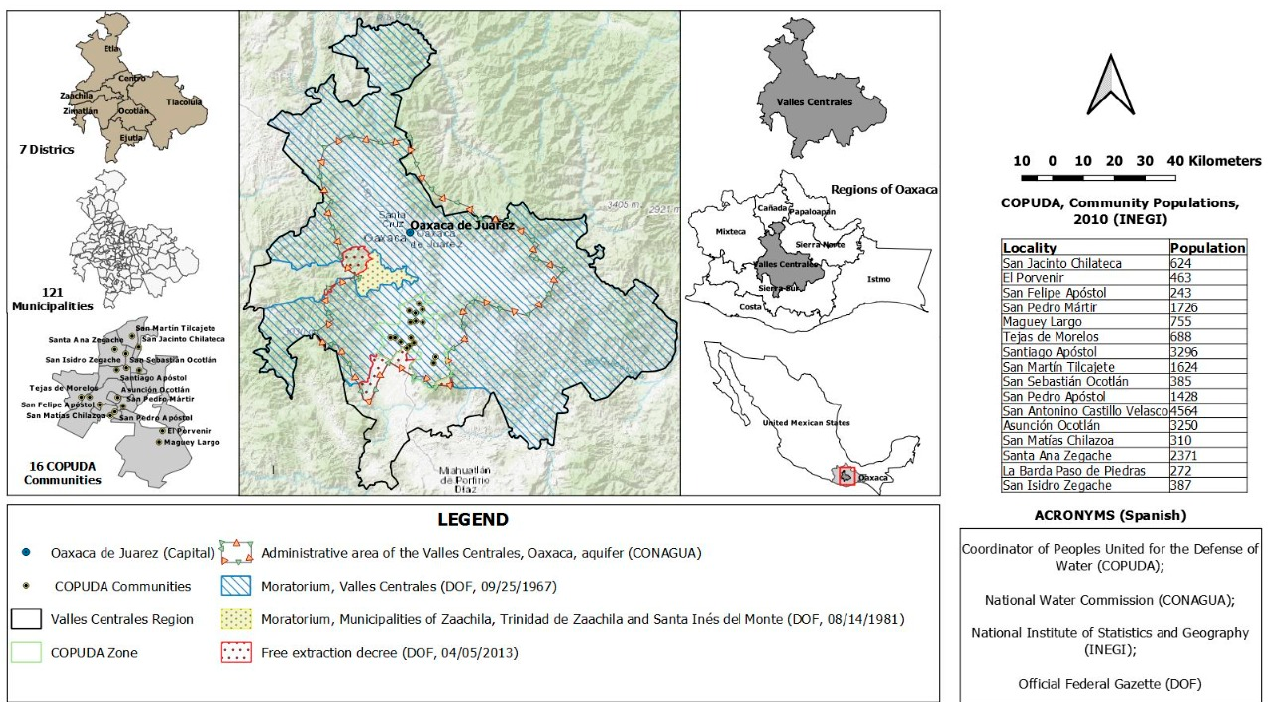
Figure 2. Location of the Valles Centrales region, Oaxaca, and of the Valles Centrales Aquifer. Source. Created with Qgis 3.14.16, with data from the Instituto Nacional de Estadística y Geografía